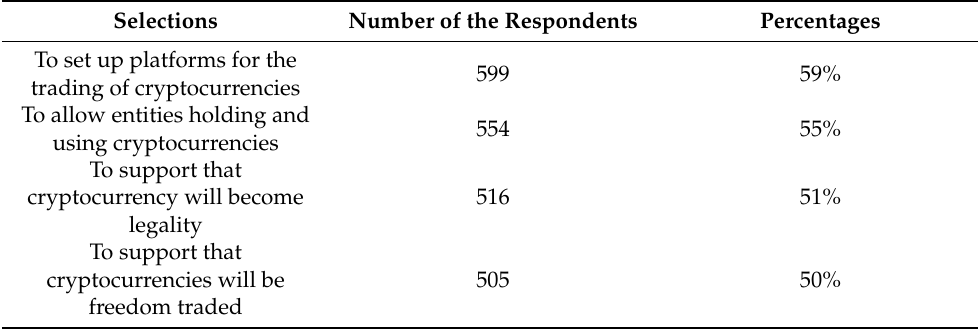
Table A23. What do you think that the legal trade of cryptocurrencies should be firstly permitted to operate and test in China’s Xiamen pilot FTZs (multiple-choice question)?